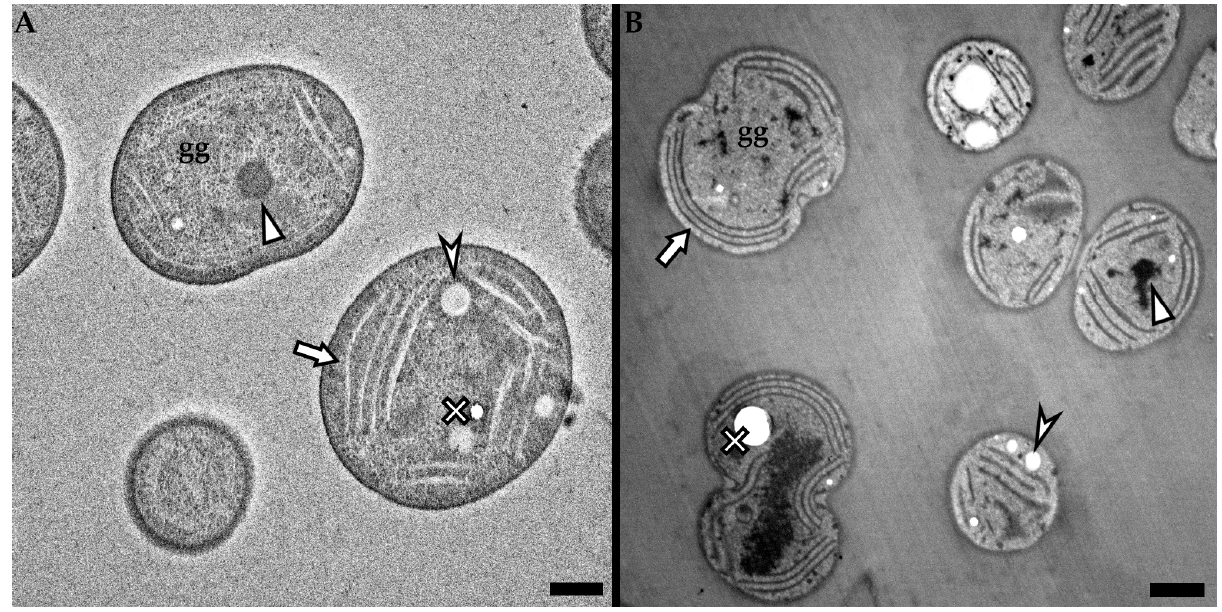
Figure 4. Intracellular structures of cyanobacterial cells were acquired using di ff erent imaging conditions. ( A ) Sample stained using uranyl acetate and lead citrate imaged using a 200 kV electron beam, ( B ) sample without staining imaged using a 25 kV electron beam. Intracellular structures marked by an arrow: thylakoid membranes; arrowhead: PHA granules; triangle: carboxysome; cross: washed-out granule; gg: glycogen granule. Scale bar: 500 nm.